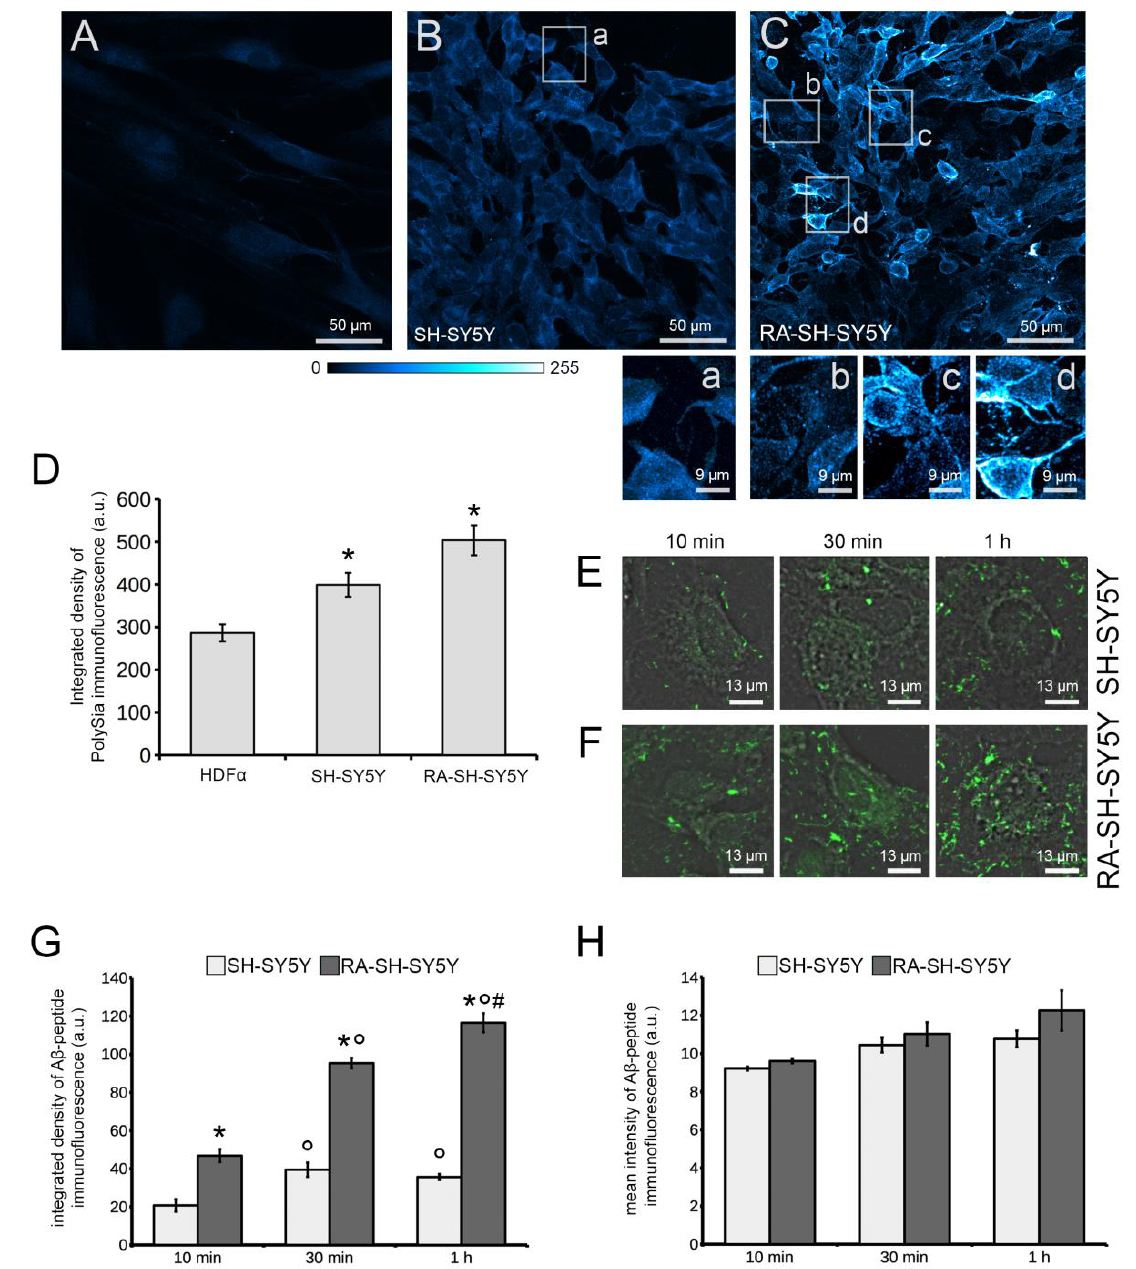
Figure 3. PolySia-specific mAb and A β -42 amyloid polyAb immunoreactivity. ( A – C ) PolySia im- munoreactivity (cyan) in HDF α , SH-SY5Y and RA-SH-SY5Y cells. Insets ( a – d ) show details of the corresponding areas selected in (( B )/( a ),( C )/( b – d )), showing PolySia immunofluorescence in cy- toplasm processes. ( D ) Quantitative analysis of PolySia immunoreactivity; n = 3, mean values of integrated density of immunofluorescence ± SE are shown, * p < 0.05 vs. HDF α . ( E , F ) Immunoreac- tivity of A β -42 Fib seeded on SH-SY5Y ( E ) and RA-SH-SY5Y ( F ) for 10 min, 30 min and 1 h; merged A β -42 immunofluorescence (green) and DIC images are shown. ( G , H ) Quantitative analyses of A β -42 immunofluorescence; values of integrated density ( G ) and mean intensity ( H ) of immunofluorescence are shown; * p < 0.01 vs. SH-SY5Y, two-way ANOVA F (1,12) = 415.5; ◦ p < 0.01 vs. 10 min, two-way ANOVA F (2,12) = 90.1, # p < 0.01 vs. 30 min, two-way ANOVA F (2,12) = 90.1. Data are reported as the average ± SE of three independent